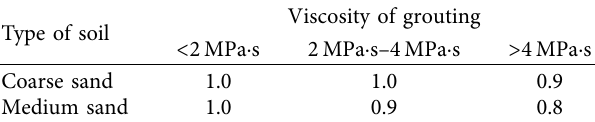
Table 1: Efective grouting coefcient a . Type of